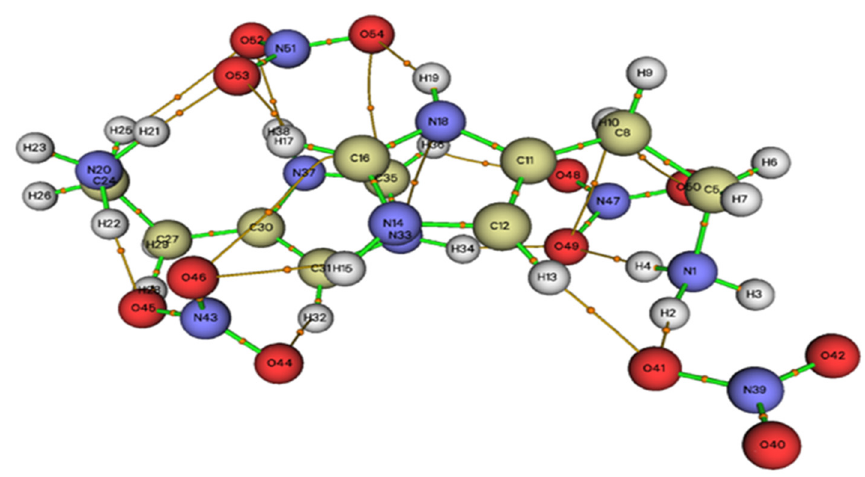
Figure 9. Graphical representation of the AIM analysis of HTN (the critical binding points (BCPs)).